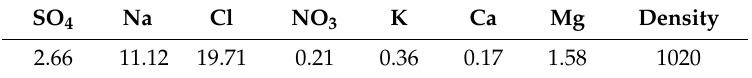
Table 2. Main constituents of seawater (kg/m 3 ) used in the leaching experiments.